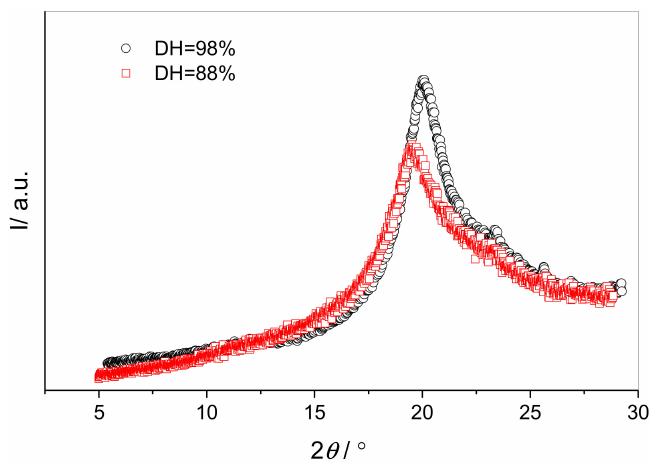
Figure 10. Superimposed XRD patterns for vacuum-dried PVA resins with degrees of hydrolysis of 88% (red) and 98%